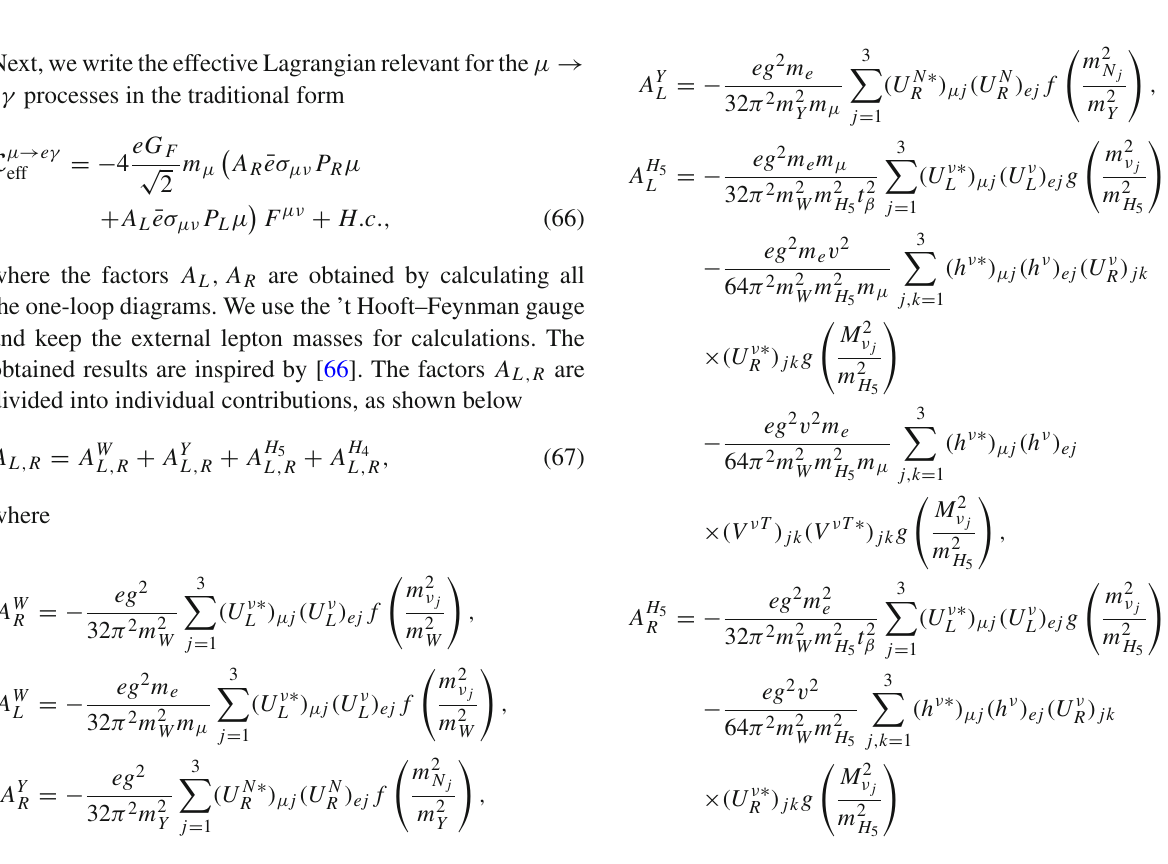
Fig. 4 The dependence of the Br ( b → s γ) on the NP scale w in the limit, u ,v (cid:14) − f u 2 + v 2 experimental constraint Br ( b → s γ) = ( 3 . 32 ± 0 . 15 ) × 10 − 4